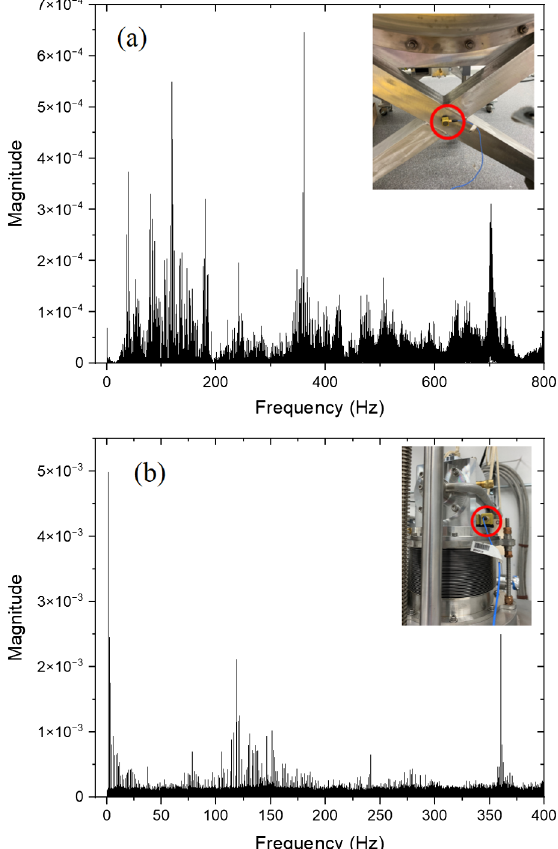
FIG. 32. Magnitude of the FFT of the vertical acceleration measured on the HTC support cart (a) and on top of CCR1 (b). The accelerometer is circled in red in the inset